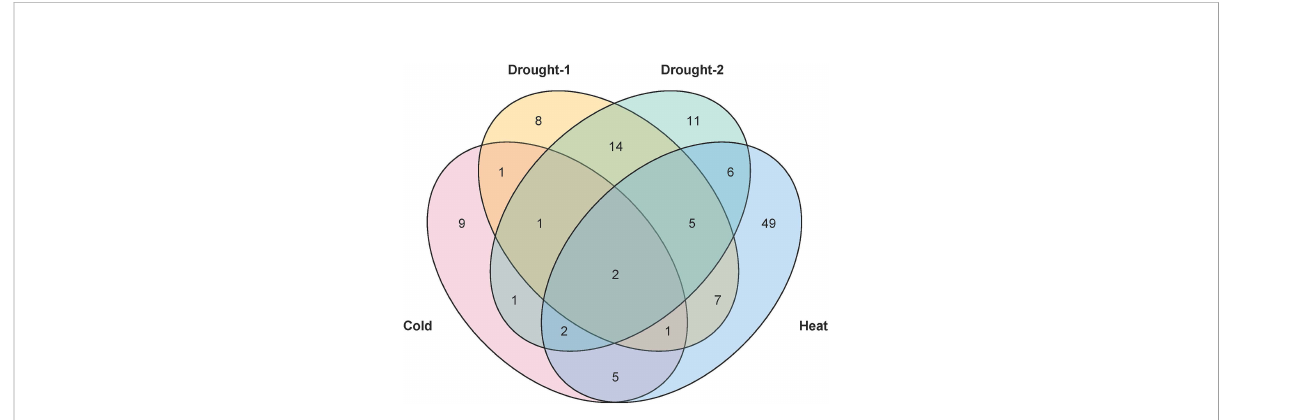
FIGURE 10 Venn diagram of DEGs in TaPHD genes during different abiotic stress. DEGs of TaPHD genes in different abiotic stress conditions, including cold stress, drought-1 (drought stress in Giza), drought-2 (drought stress in Gemmiza), and heat